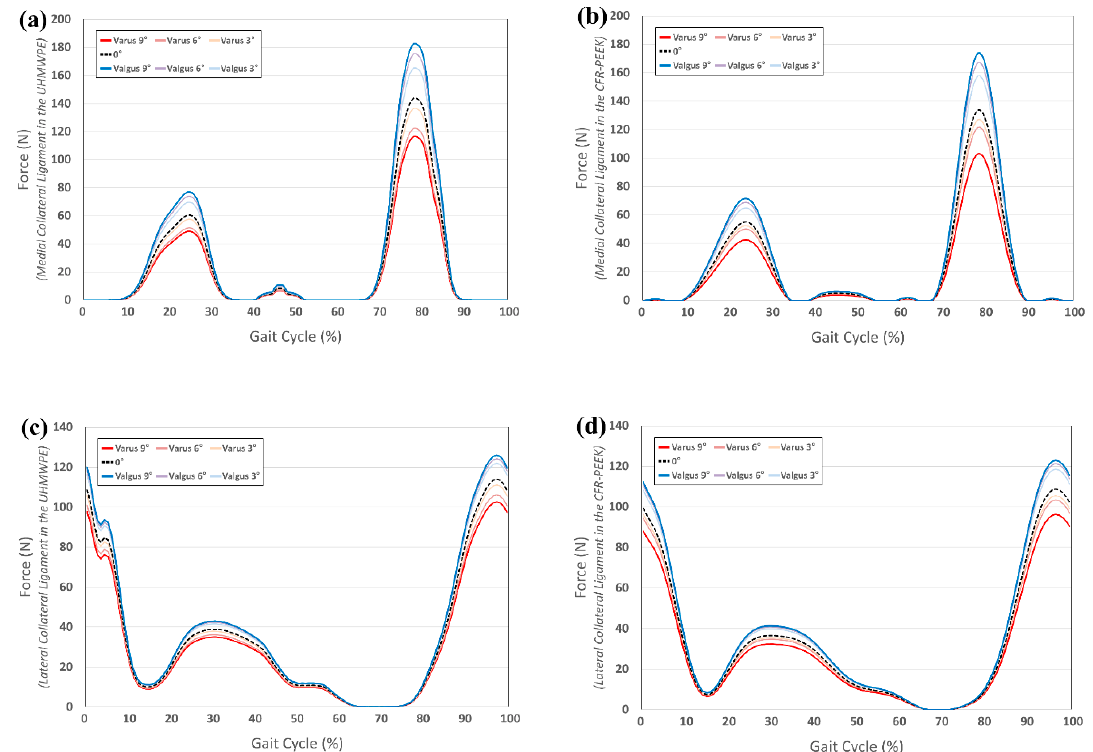
Figure 7. Comparison of ligament force in varus / valgus condition with respect to di ff erent tibial insert materials during gait cycle: ( a ) medial-collateral ligament in the UHMWPE; ( b ) medial-collateral ligament in the CFR-PEEK; ( c ) lateral-collateral ligament in the UHMWPE; and, ( d ) lateral-collateral ligament in the CFR-PEEK.